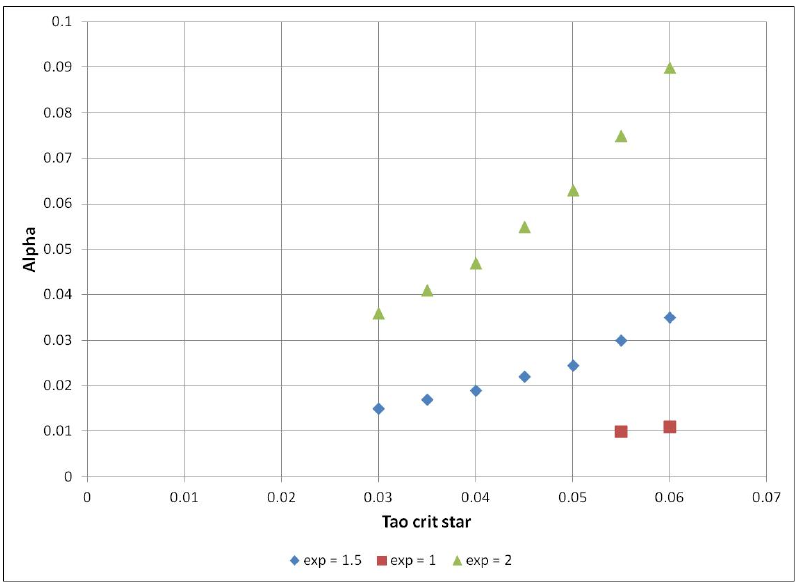
Figure 8. Example of sensitivity analysis performed at DSS2.